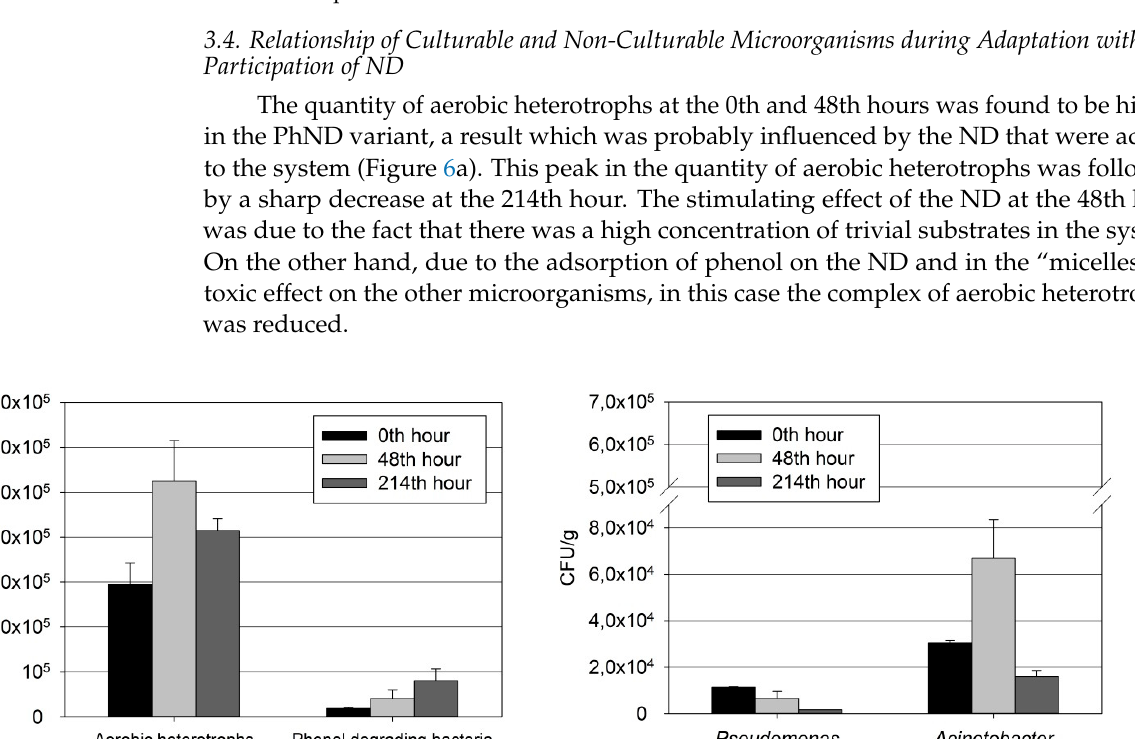
Figure 5. Percentage of non ‐ culturable bacteria of the genus Pseudomonas and genus Acinetobacter and residual phenol concentration in the variant without added ND.